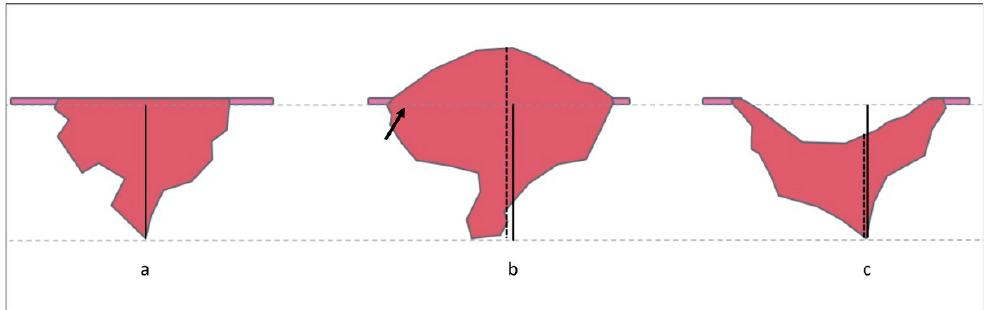
Figure 1. Cartoon demonstrating how to measure DOI in flat ( a ), exophytic ( b ), or ulcerated lesions ( c ). The reference line is the basal membrane. DOI is measured perpendicularly to the basal membrane, including ulcerated parts of the lesion, but excluding the exophytic portions. Tumor thickness is greater than DOI in exophytic lesions and smaller in ulcerated neoplasms. Solid line = DOI; dashed line = tumor thickness; arrow = basal membrane.